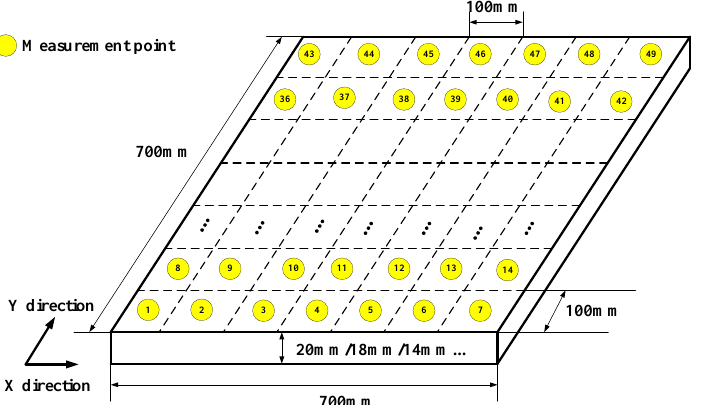
Figure 2. Schematic diagram of residual stress detection point/three coordinate measurement point diagram.